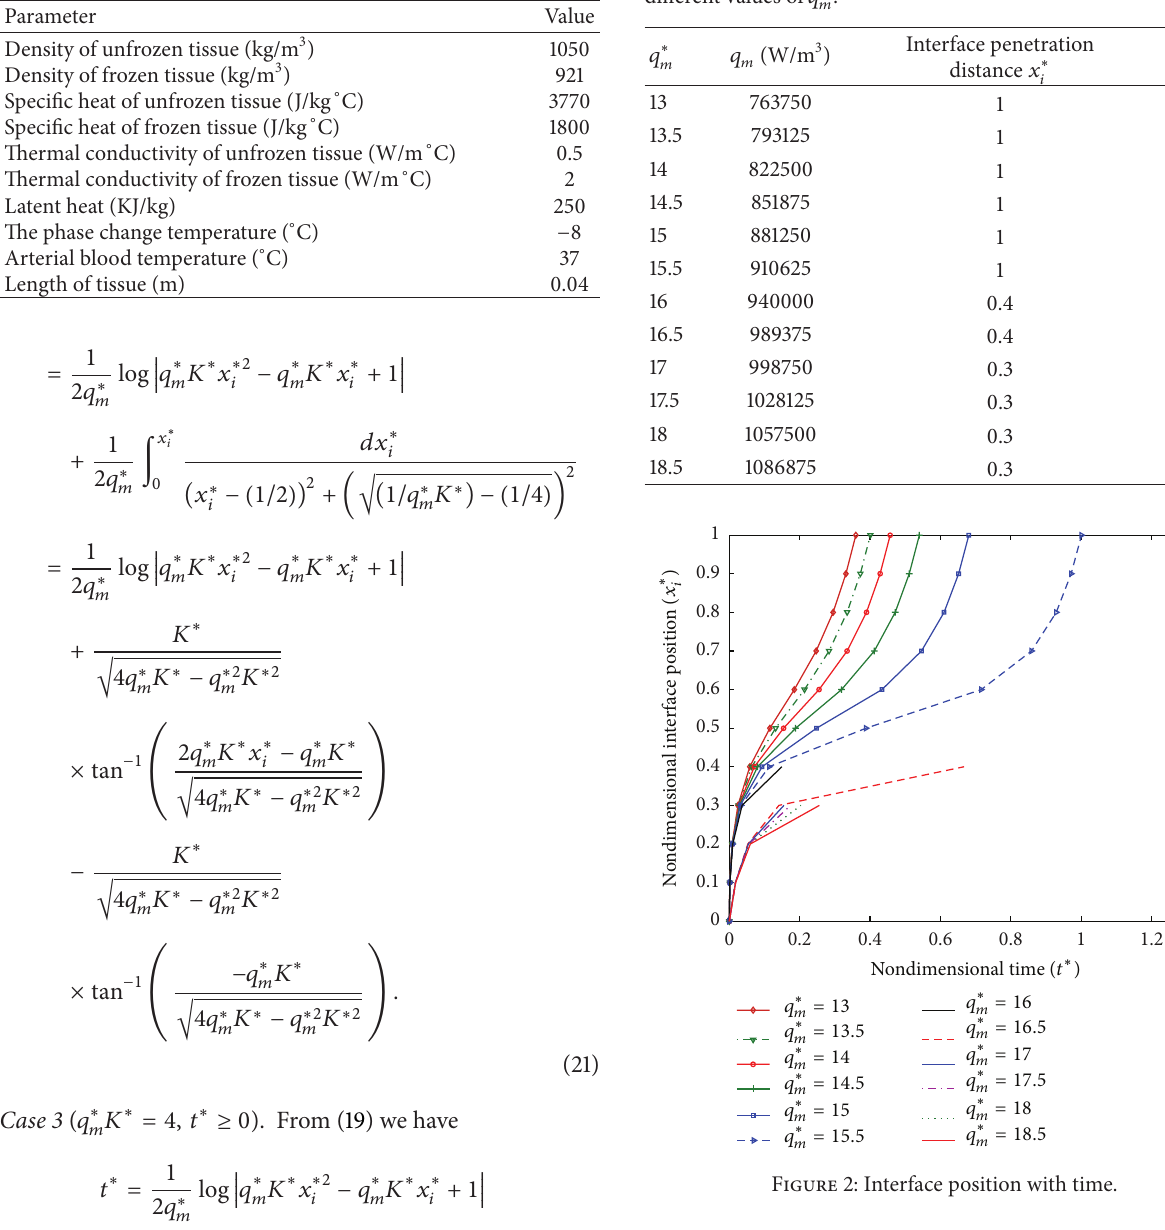
Table 1: Thermal properties of tissues [13, 23]. Table 2: Penetration distance of interface and time taken for different values of 𝑞 ∗ 𝑚 .